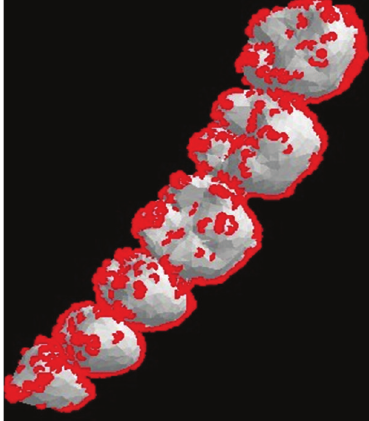
Figure 8: The results of coarse registration.